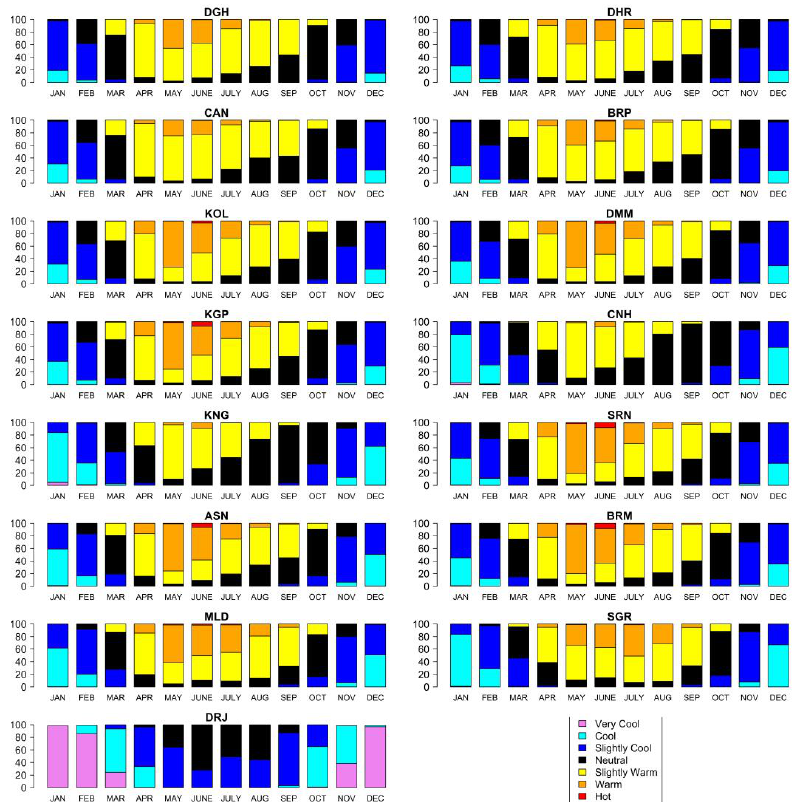
Figure 3. Intra-annual PET distribution of each category over the investigated stations extracted from the historical simulation of CORDEX (1986 – 2005). The abbreviations of each station are ex- plained in Table